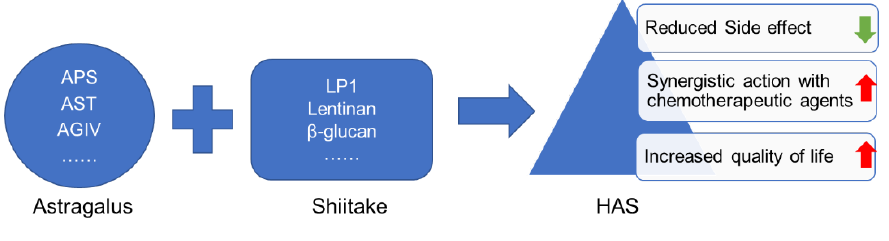
Figure 3. Potential benefits of HAS.